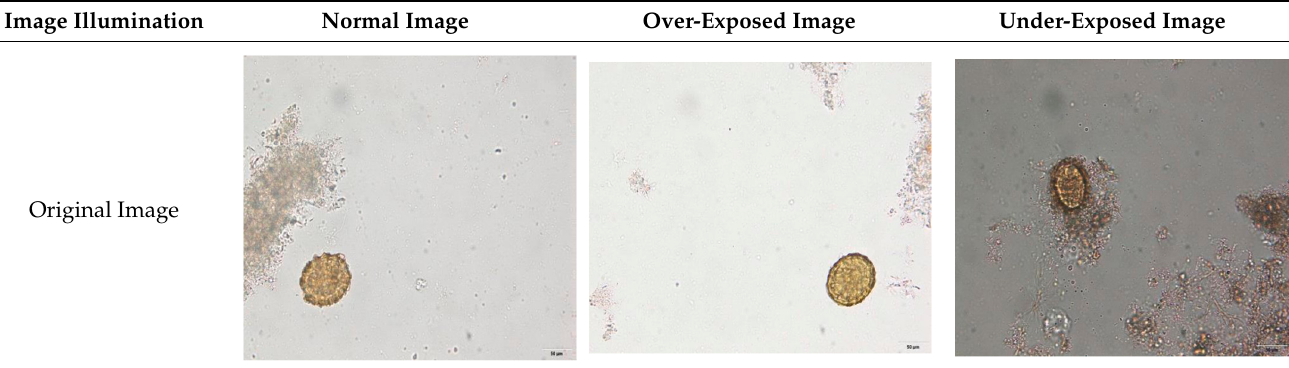
Appl. Sci. 2022 , 12 , 7542